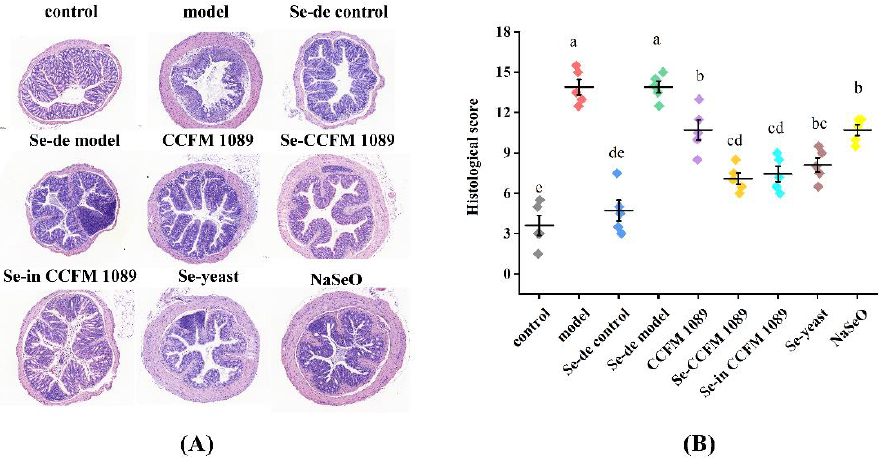
Figure 4. Effects of different Se forms on the histological injury in the colon with colitis. ( A ) Histological examination (the scale bar is 100 μm). ( B ) Colon tissue injury scores. Graphs show mean ± SD; n = 5. Significant differences are indicated by different superscript letters ( p < 0.05), and the same superscript letters above the bars indicate that the differences between the values are not statistically significant ( p > 0.05).